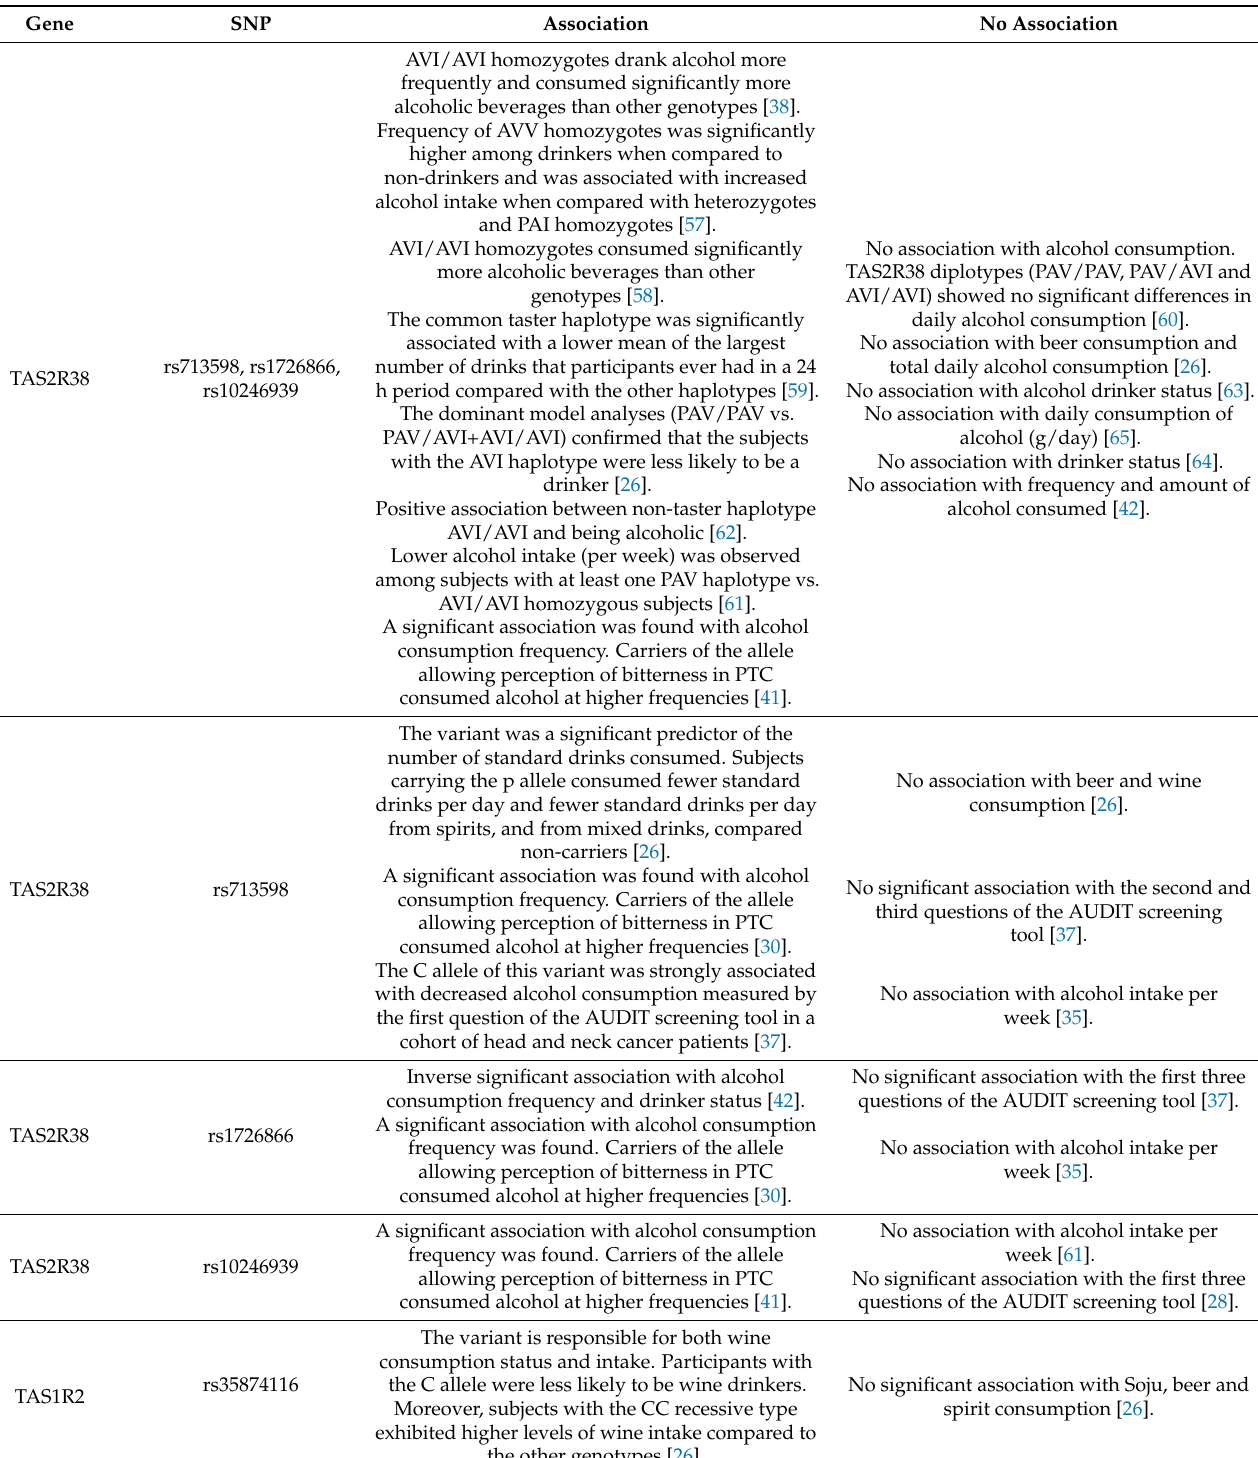
Table 3. Overview of the effect of taste preference-related gene polymorphisms on alcohol